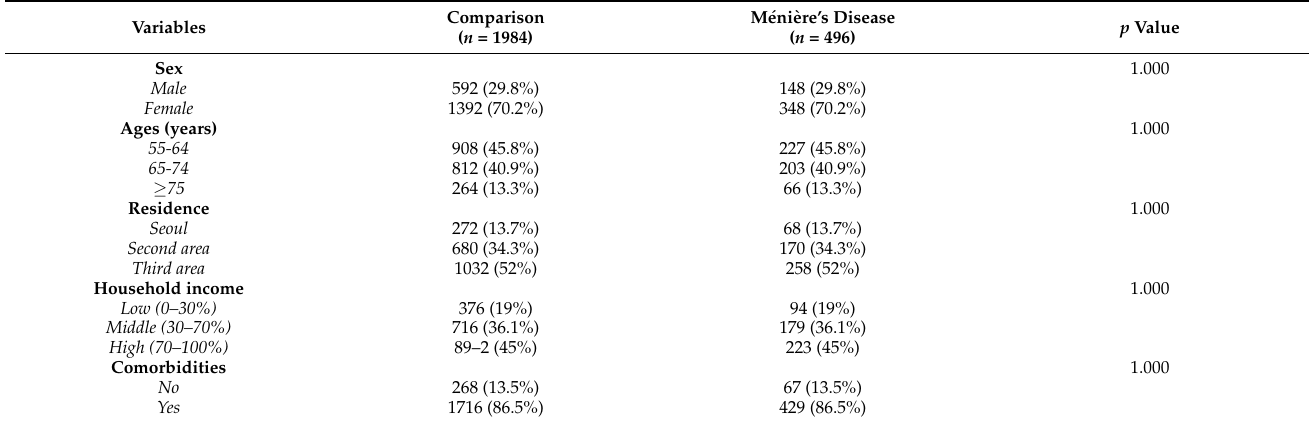
Figure 2. Balance plot for five variables before and after matching. Table 3. Characteristics of the study